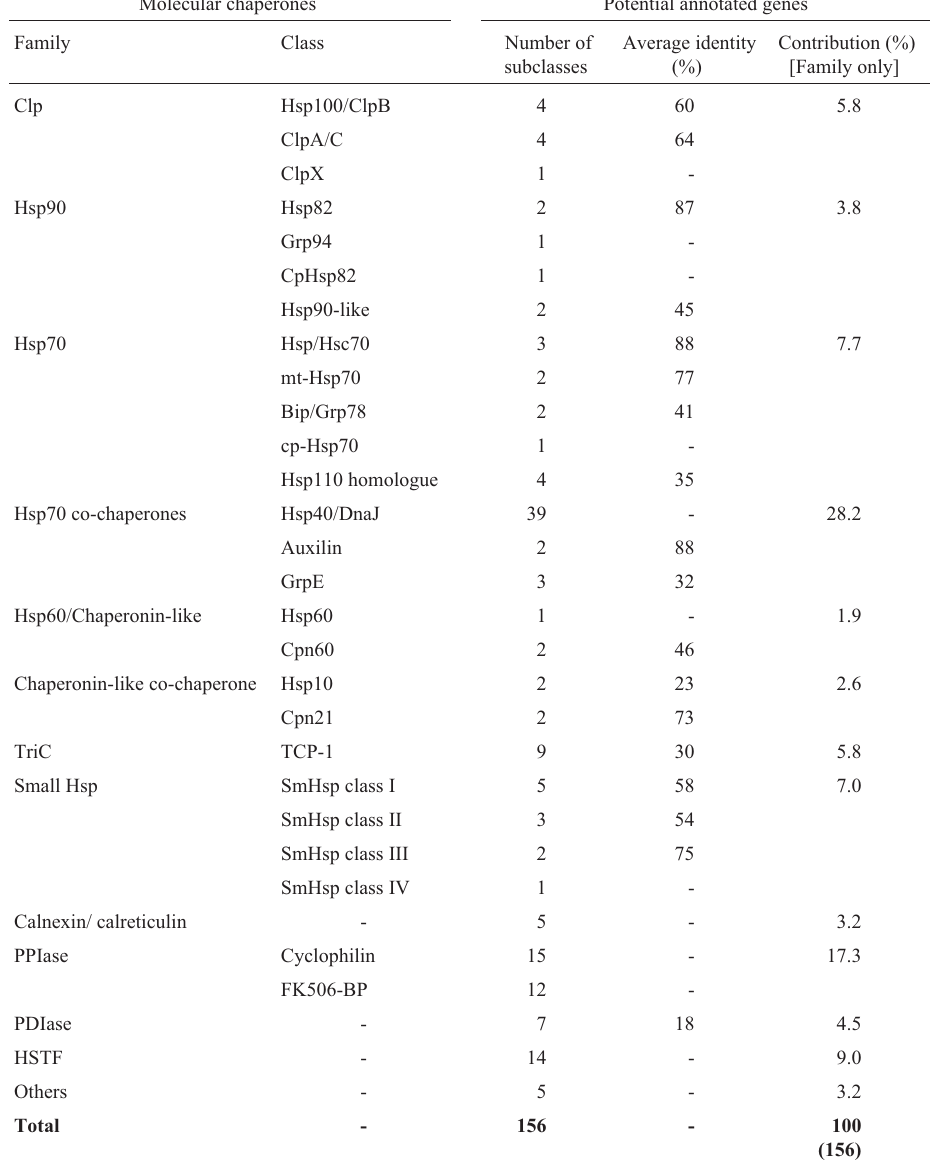
Table II - The number of potential annotated chaperone